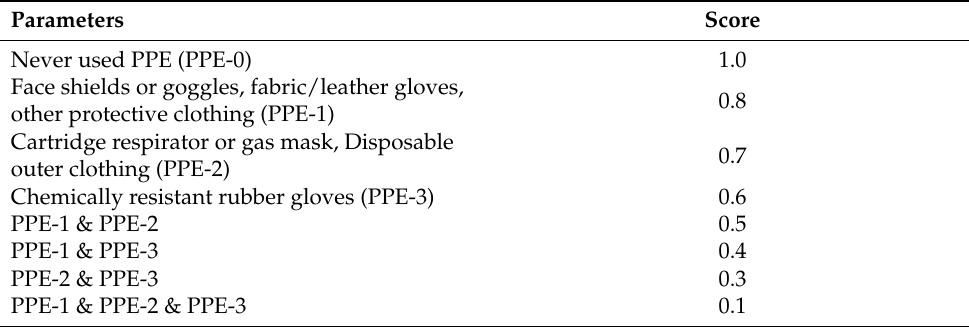
Table 1. Scoring for personal protective equipment